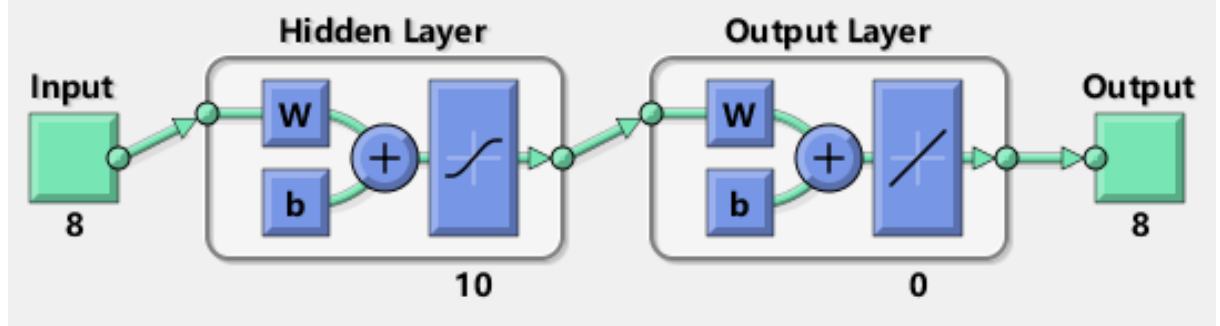
Figure 2. The BP neural network model of economic benefit dimension.